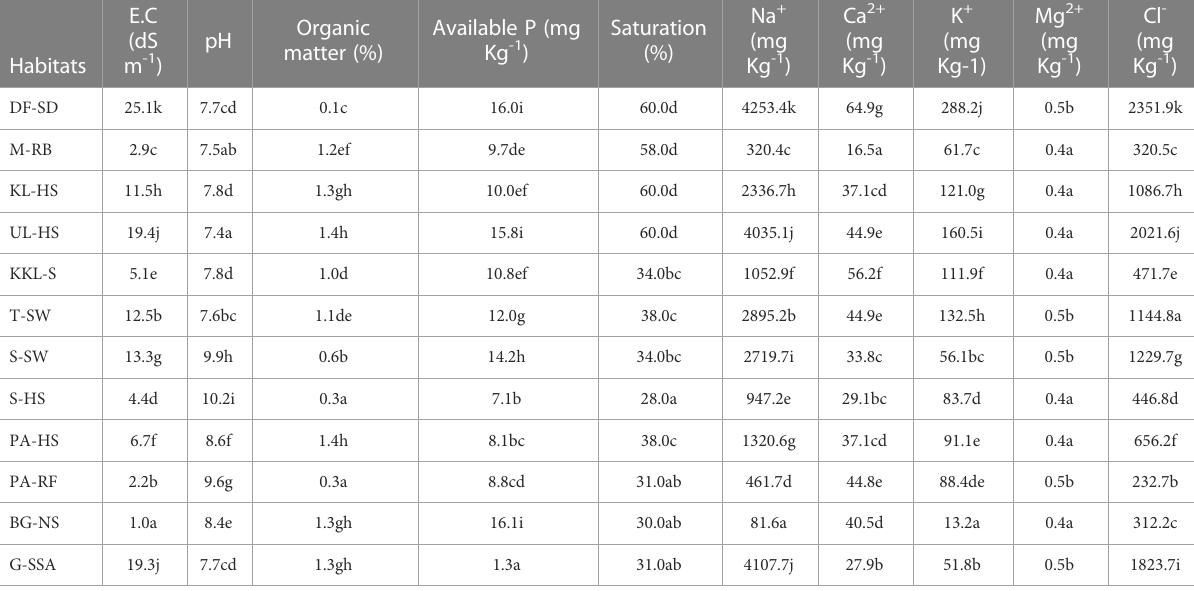
TABLE 1 Soil physio-chemical characteristics of the selected habitats from Punjab, Pakistan.